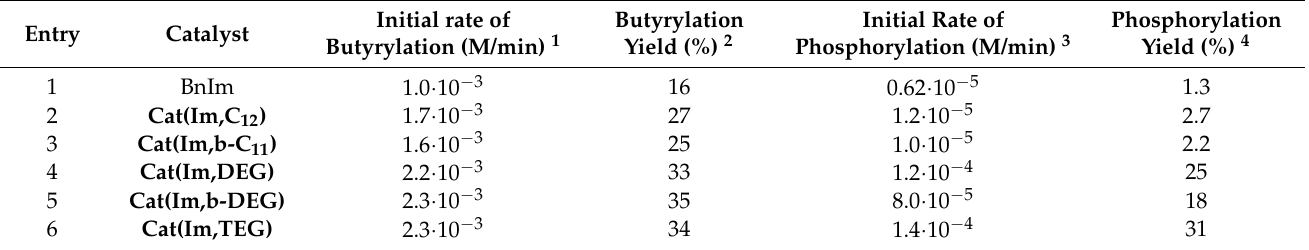
Table 1. Butyrylation and phosphorylation of substrate 4 , promoted by the catalysts of the Im family, as depicted in Scheme 2.